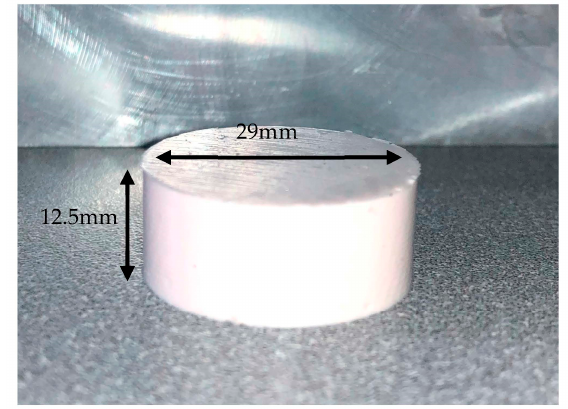
Figure 1. ATSM D395 Silicone test